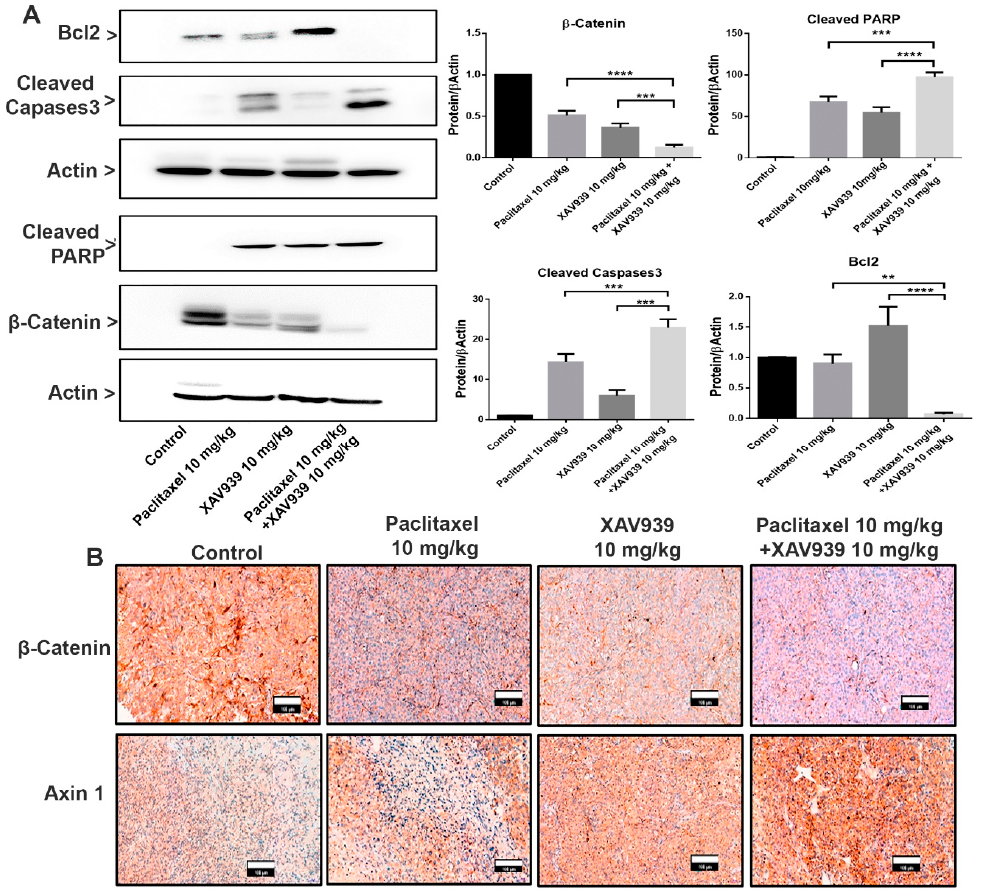
Figure 5. Combination treatment promoted the proapoptotic protein expression and suppressed the Wnt signaling pathway in an in vivo xenografted breast tumor model. ( A ) Tumor lysates were obtained, and the protein expression levels of β -catenin, cleaved PARP, Bcl2, and cleaved caspases3 were analyzed by the Western blot. Bar graphs represent the protein expression levels, which were normalized to the expression level of actin and quantified by densitometry from three different experiments (mean ± SD, n = 3; **: p < 0.01, ***: p < 0.005, and ****: p < 0.001, compared with each single treatment with paclitaxel or XAV939). ( B ) Tumor sections were subjected to immunohistochemical analysis of β -catenin and Axin1 using respective antibodies and were stained by diaminobenzidine (DAB, dark-brown staining). Photographs were taken at a magnification of 20 × . Scale bar = 100 µ